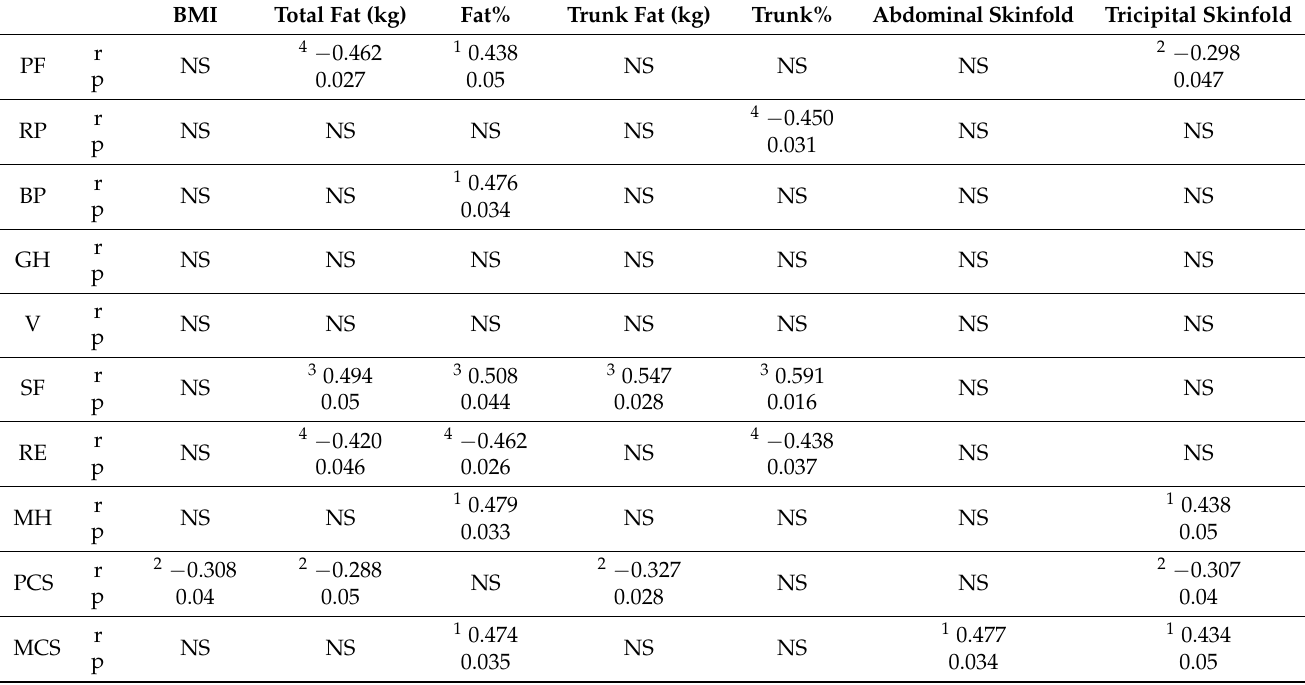
Table 4. Correlations between quality of life scales and weight/obesity